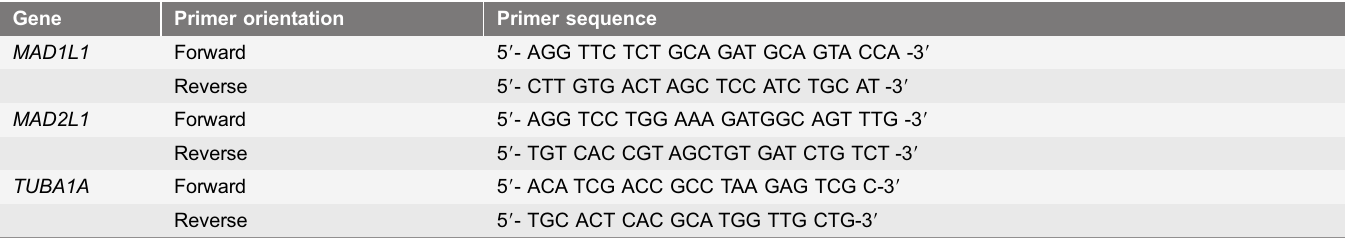
Table 2. Primer sequences used for detection of human genes in VK2/E6E7 cells by qPCR.